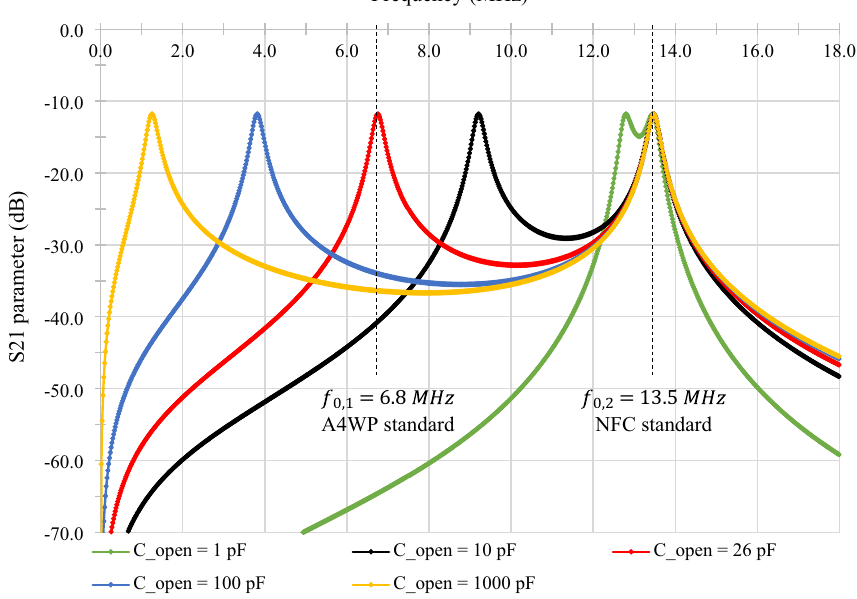
Figure 4. Simulations of the dual-band combiner’s S 21 parameter for C open = [1pF, 10pF, 26pF, 100pF, 1000pF] from 1 to 18 MHz (Simulated values by